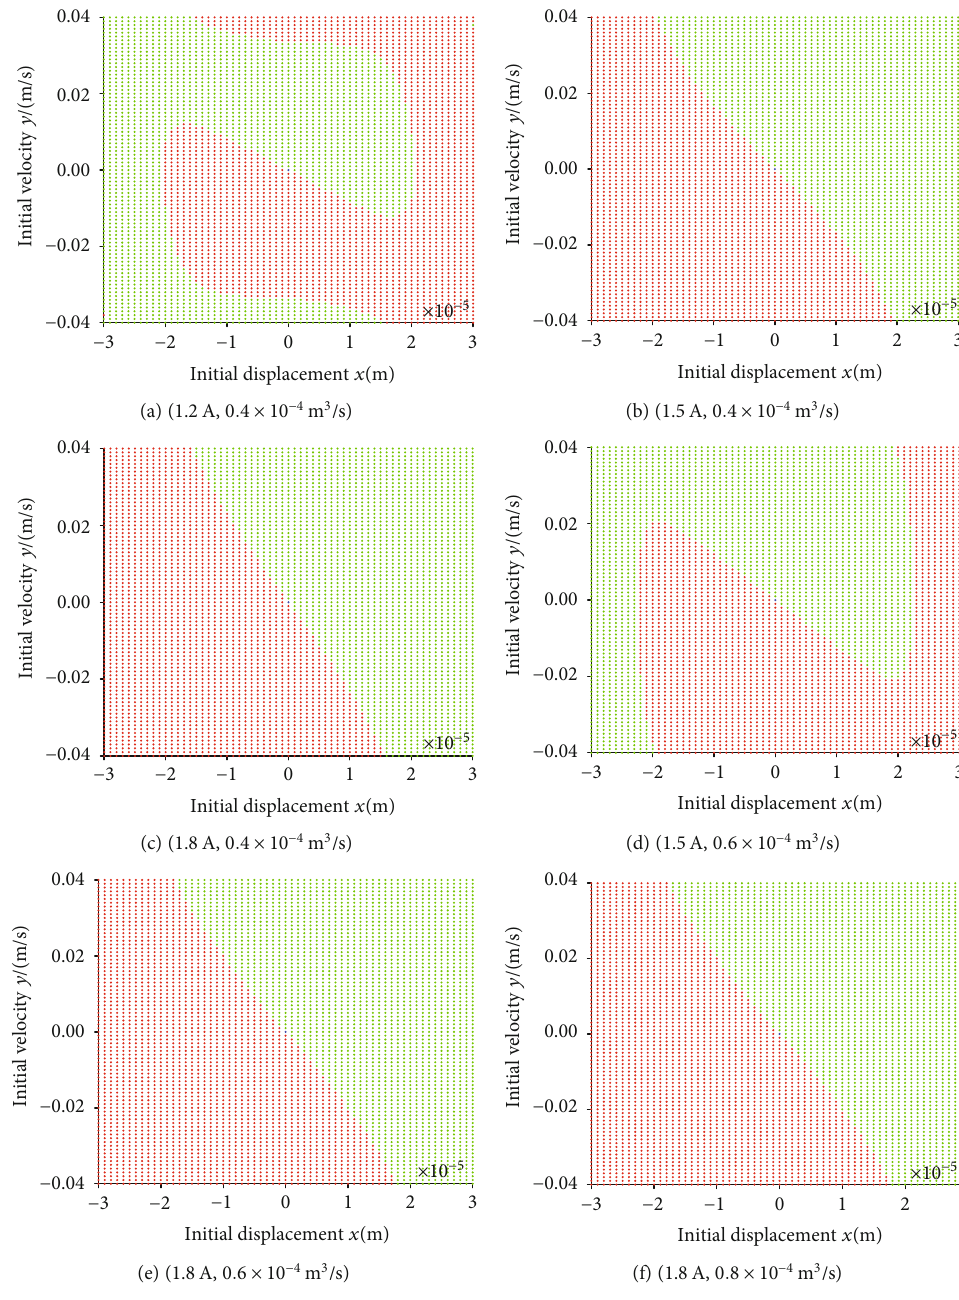
Figure 27: Basins of attraction under di ff erent